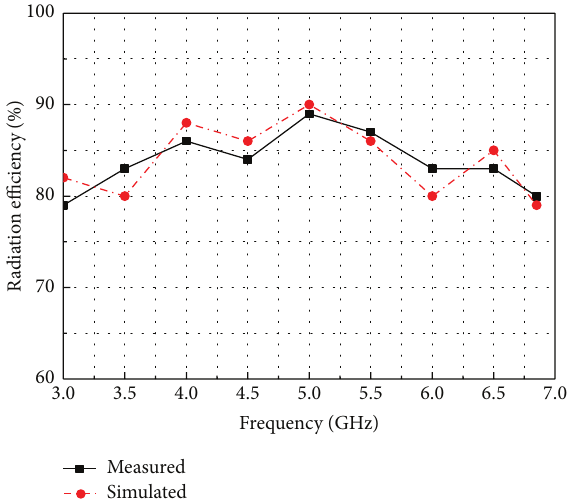
Figure 13: Measured and simulated radiation efficiency of the proposed